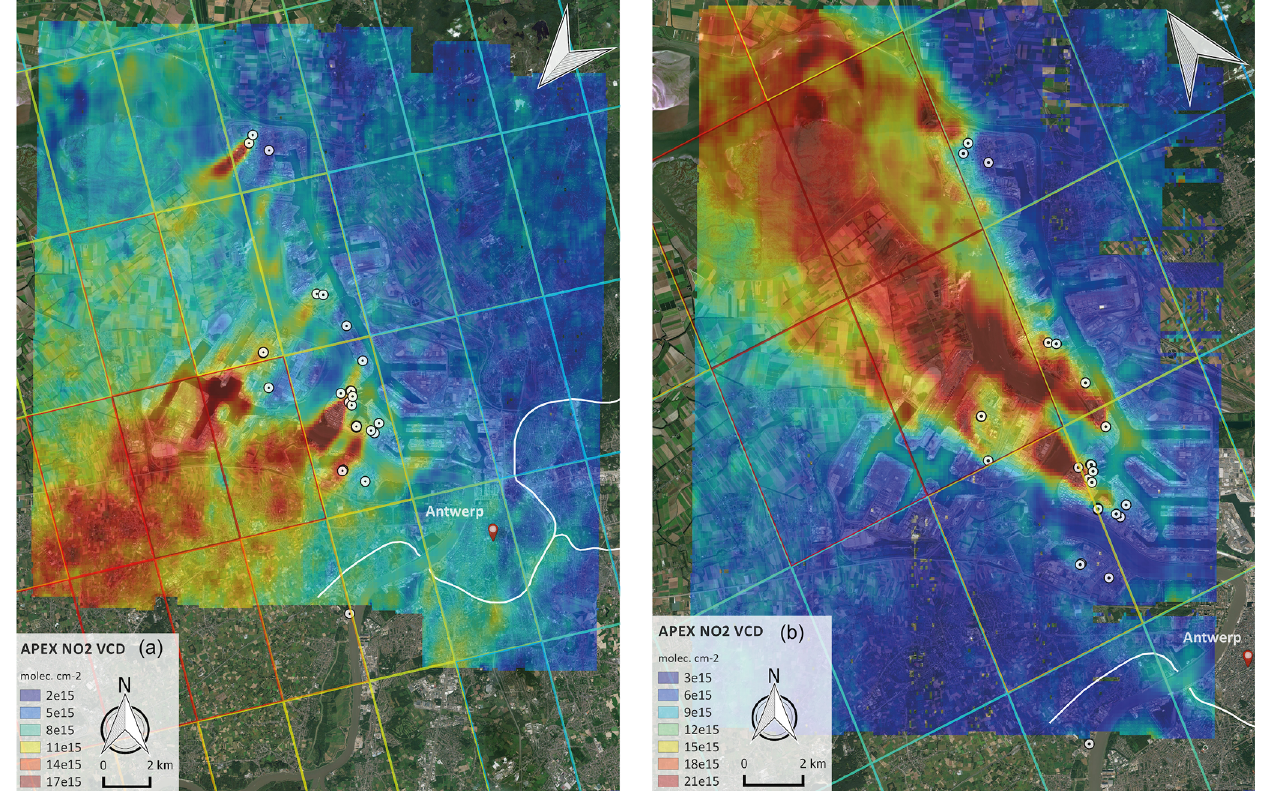
Figure 6. Tropospheric NO 2 VCD grids retrieved over Antwerp on (a) 27 June (Flight no. 2) and (b) 29 June (Flight no. 4) 2019. Note that different colour scales were applied in order to optimize the dynamic range of each data set. White dots indicate the point sources, emitting more than 10kg of NO x per hour, according to the emission inventory (2017) of the Belgian Interregional Environment Agency. Line sources such as the key highways and city ring road are indicated by white lines. Coinciding TROPOMI tropospheric NO 2 VCD retrievals are overlain as colour-coded polygons. White wind vectors indicate the surface wind, averaged over the APEX acquisition time, as provided in Table 1 (© Google